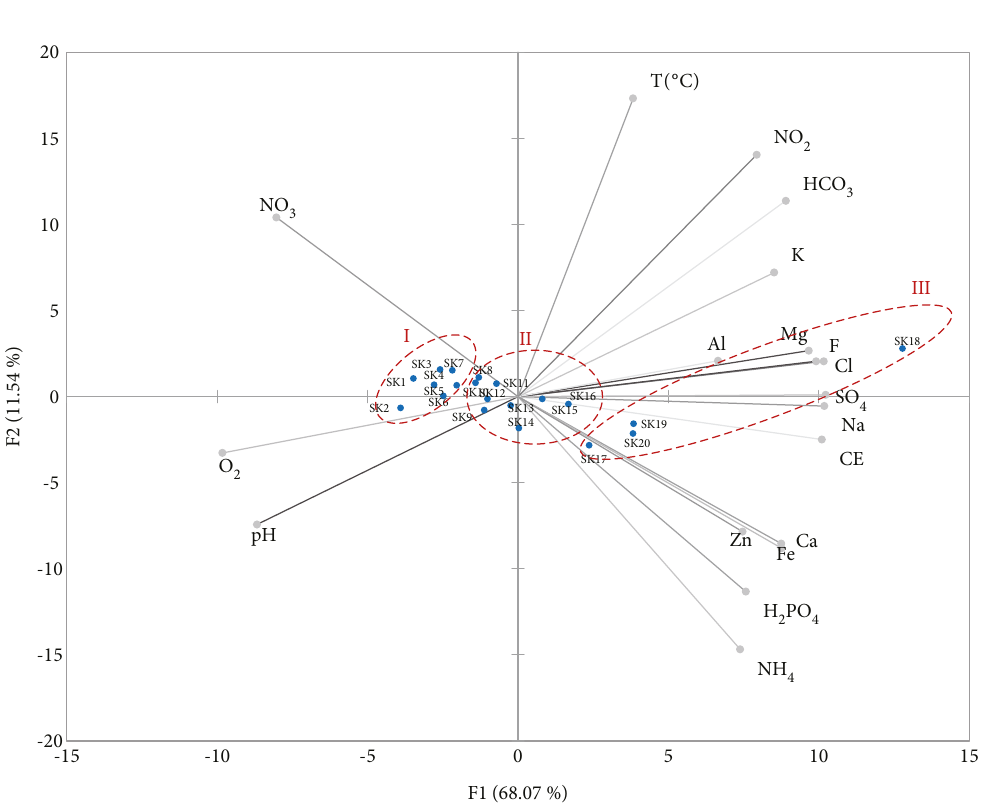
Figure 9: Spatial distribution of the variables and individuals in the axis system F.